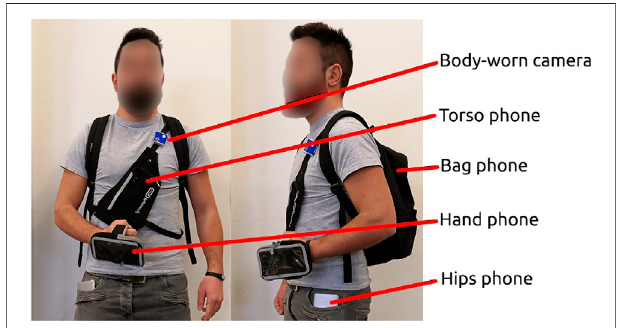
FIGURE 1 | A participant carrying four smartphones and a wearable camera when collecting the dataset. The camera was used to ensure high